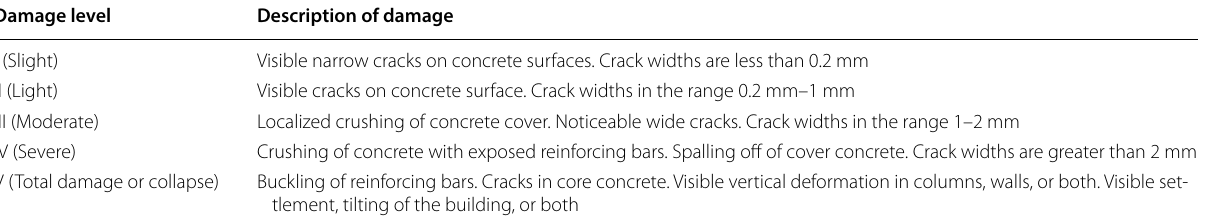
Table 1 Definition of damage levels of structural members (JBDPA 2001). Damage level Description of damage